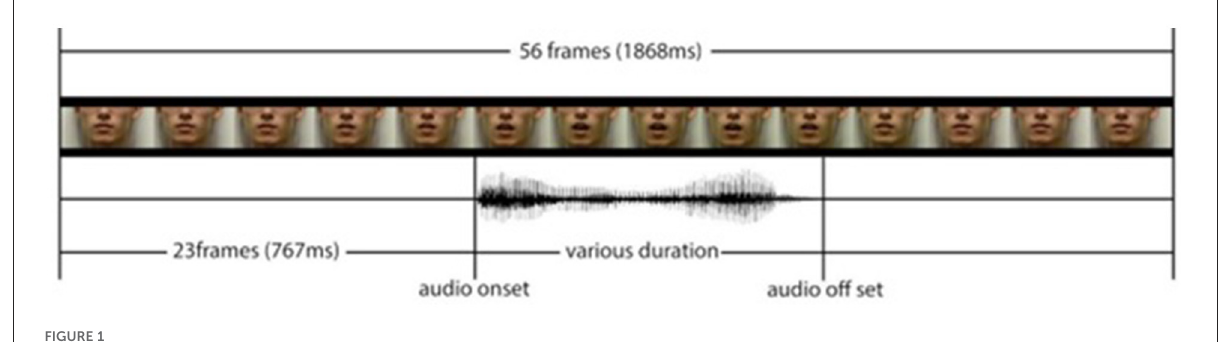
FIGURE1 Trial structure in both